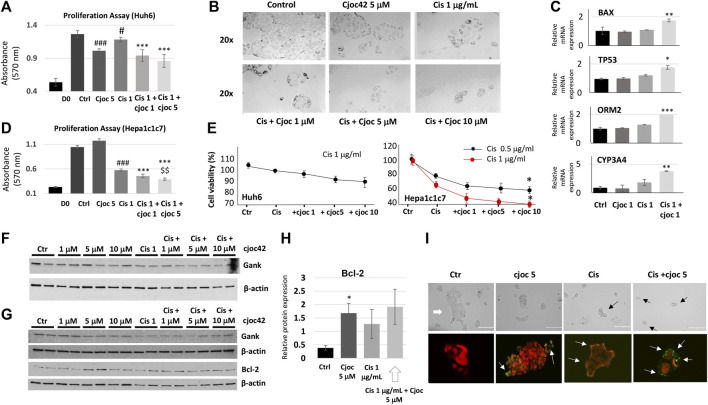
Combination treatment of cancer cell lines with Cjoc42 and cisplatin leads to stronger inhibition of proliferation compared to monotherapy. (A) Proliferation assay in Huh6 cells treated with Cjoc42 alone, cisplatin alone, or a combination of Cjoc42 and cisplatin. D0 shows the number of cells at the time of plating. Statistically significant reduction in proliferation is seen when comparing control to Cjoc42 5 µM (p < 0.0001), control to cisplatin 1 µg/mL (p < 0.02), cisplatin 1 µg/mL to cisplatin + Cjoc42 1 µM (p < 0.0001), and cisplatin 1 µg/mL to cisplatin + Cjoc42 5 µM (p < 0.0001). (B) Microscope pictures at 20x magnification show a reduction in number and cluster of Huh6 cells when treated with cisplatin and increasing concentrations of Cjoc42. (C) QRT-PCR data in Huh6 treated cells shows an increase in apoptotic markers Bax and TP53 with concomitant treatment as well as an increase in mature hepatocyte markers ORM2 and CYP3A4. (D) Proliferation assay in Hepa1c1c7 cells treated with Cjoc42 alone, cisplatin alone, or a combination of Cjoc42 and cisplatin. Statistically significant reduction in proliferation is seen when comparing control to cisplatin 1 µg/mL (p < 0.0001), cisplatin 1 µg/mL to cisplatin + Cjoc42 1 µM (p < 0.0001), cisplatin 1 µg/mL to cisplatin + Cjoc42 5 µM (p < 0.0001), and cisplatin + Cjoc42 1 µM to cisplatin + Cjoc42 5 µM (p < 0.008). (E) Left: Cytotoxicity Assay with cisplatin 1 μg/mL and increasing concentrations of Cjoc42 (1 μM, 5 μM, and 10 µM) in Huh6 cells. Right: Cytotoxicity Assay with cisplatin 1 µg/mL and increasing concentrations of Cjoc42 (1 μM, 5 μM, and 10 µM) in Hepa1c1c7 cells. A statistically significant difference was seen in cell viability between cisplatin 0.5 µg/mL or 1 µg/mL dose alone vs. in combination with Cjoc42 10 µM (p < 0.01 and p < 0.04, respectively. (F) Western blot analysis of Huh6 cells treated with cisplatin 1 µg/mL and increasing concentrations of Cjoc42. (G) Western blot analysis of Hepa1c1c7 cells treated with cisplatin 1 µg/mL and increasing concentrations of Cjoc42. A statistically significant difference was seen in cell viability between cisplatin 0.5 µg/mL or 1 µg/mL dose alone vs. in combination with Cjoc42 10 µM (p < 0.01 and p < 0.04, respectively). (H) A statistically significant difference in Bcl2 is seen comparing control cells to Cjoc42 5 µM (p < 0.03). (I) TUNEL assay of Huh6 cells treated with Cjoc42 (5 µM), cisplatin (1 µg/mL), and with combination cisplatin plus Cjoc42. The upper panel shows typical microscope pictures of the same cells before staining. White arrow shows a big colony of untreated Huh6 cells, black arrows show small colonies in treated cells. Bottom images show the merge of the staining with Propidium Iodide/RNase A (red) and FITC-dUTP (green).